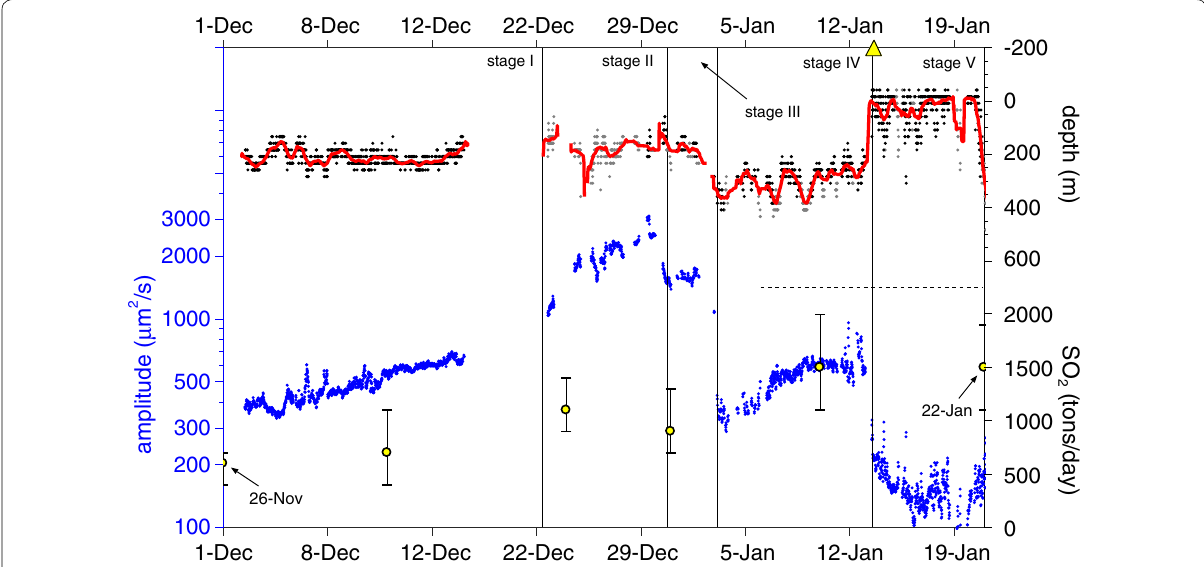
Fig. 11 Time evolution of the source amplitude and the depth of continuous tremors. The estimated source amplitude A 0 (blue dots) and source depth (black and gray dots; as in Fig. 8a) are plotted with respect to time. The red lines show the 24-hour moving average of the depth data. SO 2 discharge rate is also potted again by yellow circles (Japan Meteorological Agency 2014). The yellow triangle at the top of the diagram indicates the reported eruption (Japan Meteorological Agency